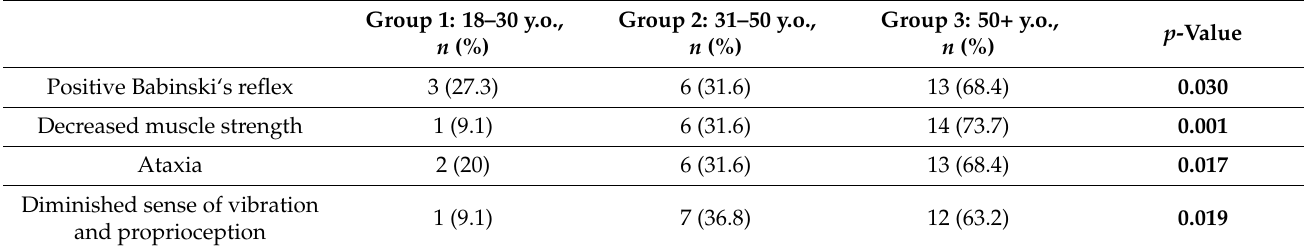
Table 3. Distribution of clinical features in accordance with age groups.